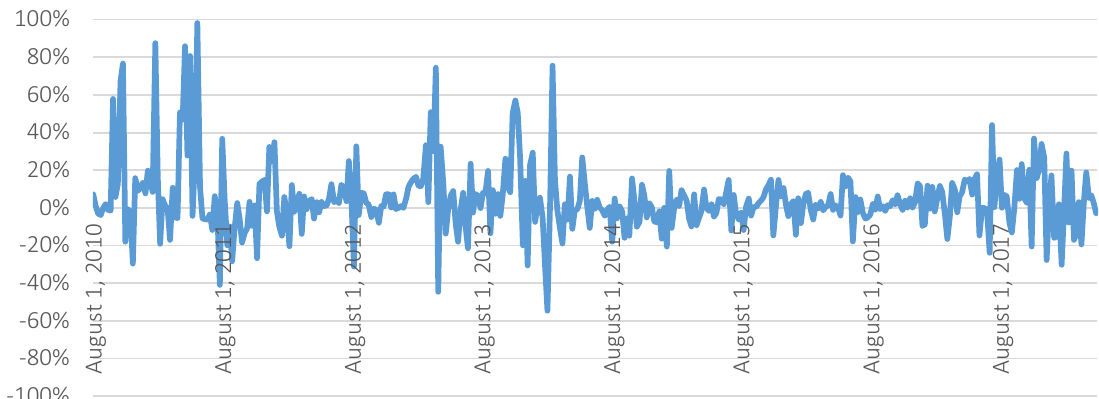
Figure 6. Returns for the Bitcoin